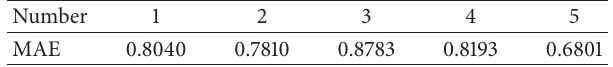
Table 3: Error of different test samples of tapered dual-plane EBG.